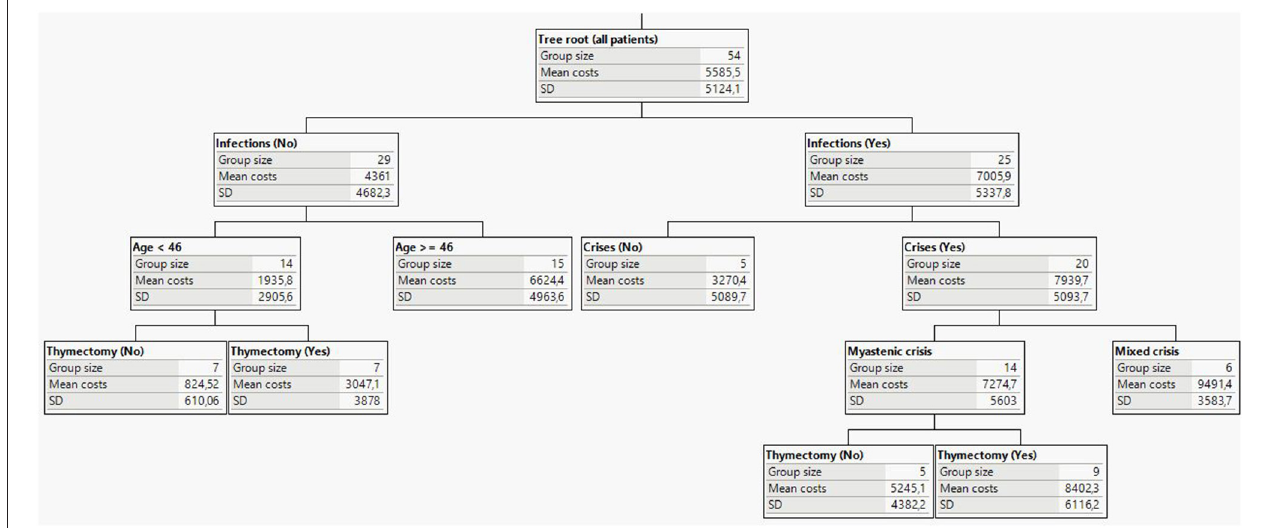
FIGURE 2 | Decision tree analysis and main predicting factors for MG socio-economic burden (costs in